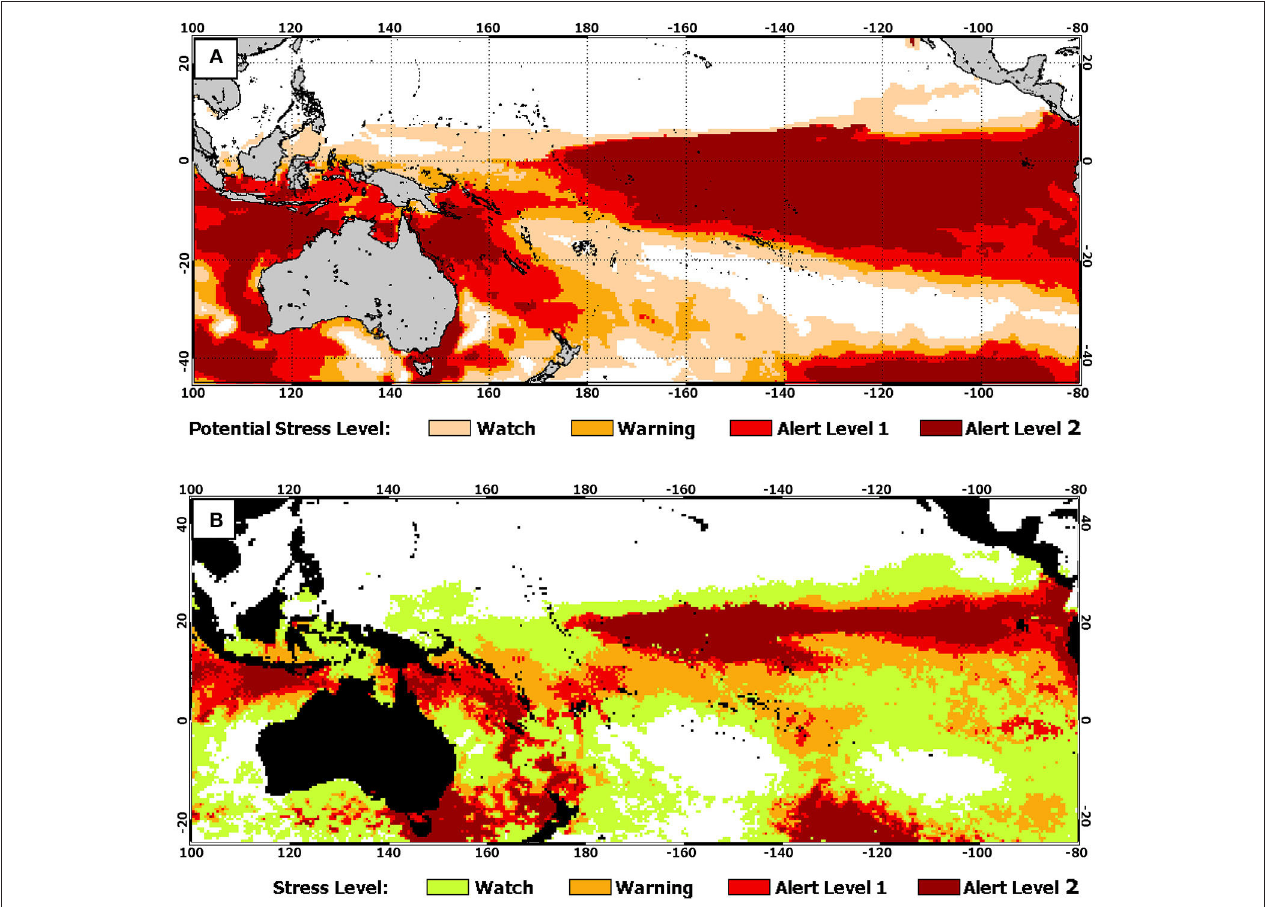
FIGURE 14 | CRW’s (A) 4-Month Outlook (Version 3) of 60% probability issued on December 1, 2015 for December 2015–March 2016, predicting Alert Levels 1 and 2 on the Great Barrier Reef (GBR) and in the waters off southeast Australia during the region’s 2016 summer, and the (B) monthly maximum 50km satellite Bleaching Alert Area for March 2015, observing Alert Levels 1 and 2 in the regions.